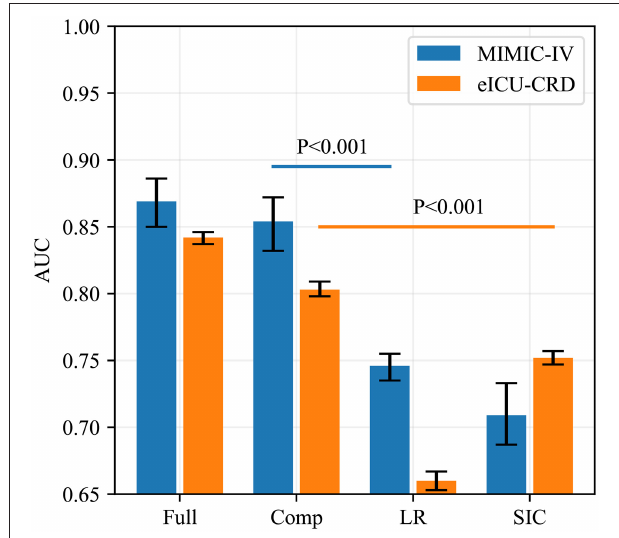
Supplementary Table 4 . The optimized CatBoost model had the